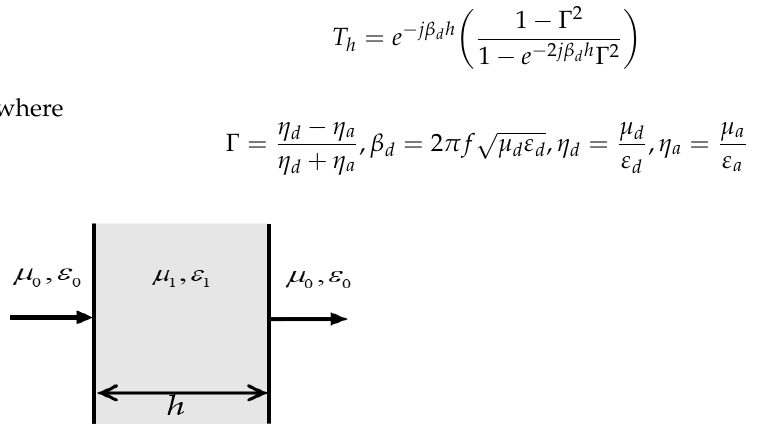
Figure 2. Transmission of millimeter wave at normal incidence on dielectric slab with a thickness of h . μ a and μ d are the permeability of free space and dielectric material, respectively; ε a and ε d are the permittivity of free space and dielectric material, respectively.